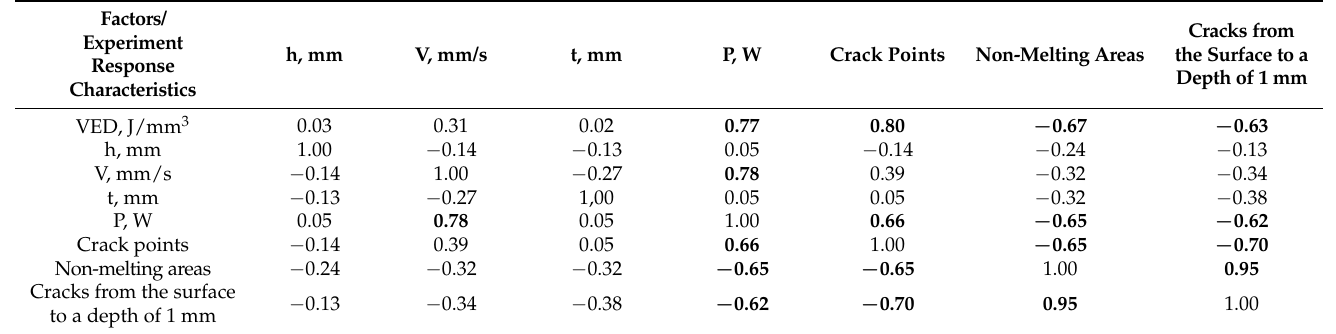
Table 3. Pearson correlation